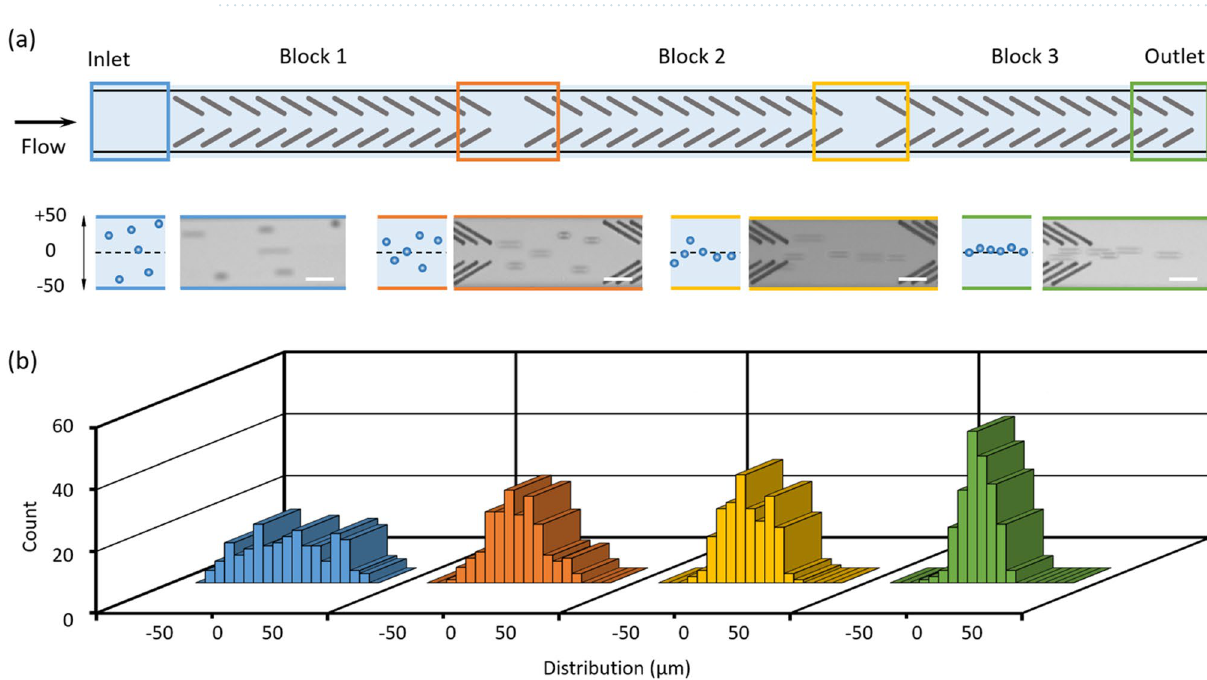
Figure 4. Effect of open v-shaped patterns on particle focusing. ( a ) Schematic illustration of a microfluidic channel having three blocks of groove arrays. Schematics and superimposed experimental images depicting the distributions of polystyrene particles at the inlet, after passing block1, 2 and 3 (outlet) are shown. Scale bar is 40 µm. ( b ) Plots of the lateral distributions of particles along channel width. The length of one block is 1980 µm and the distance between neighboring two blocks is 220 µm. The distributions of particles at four different locations are recorded and compared: inlet (before passing block 1), after passing block 1, 2, and 3 (outlet). 200 particles are measured for each